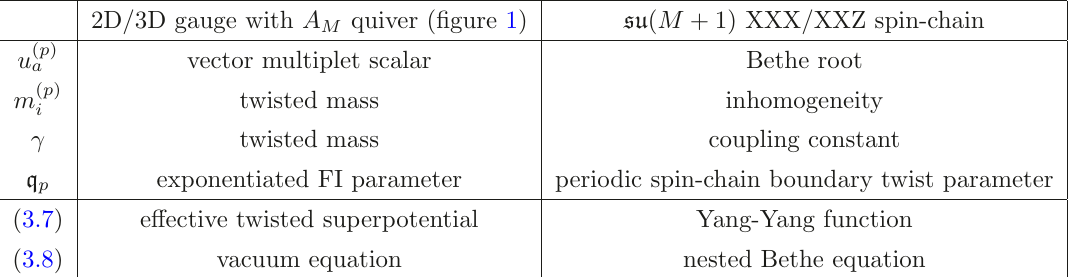
Table 2 . The Bethe/Gauge dictionary, where a = 1 , . . . , k p , i = 1 , . . . , L p , p = 1 , . . . , M . Here k p is the number of vector multiplet scalars in U ( k p ) on the gauge side/spin excitations on the Bethe side, and L p is the number of (anti-)fundamental flavors in U( k p ) on the gauge side/total number of spins on the Bethe